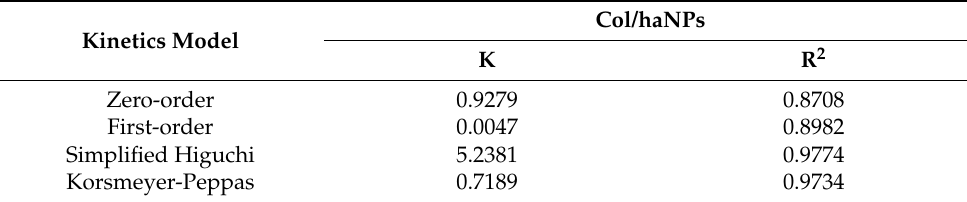
Table 2. Rate constants and correlation coefficients obtained from modeling Col release kinetics from Col loaded haNPs through the following mathematical kinetic models: zero-order kinetic model, first-order kinetic model, simplified Higuchi model and Korsmeyer–Peppas model. Kinetics